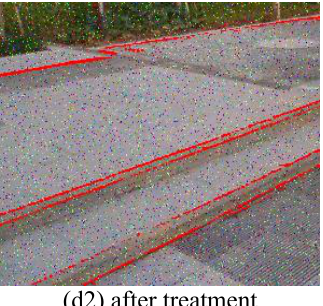
Figure 8. Contrast images of pillars and steps before and after